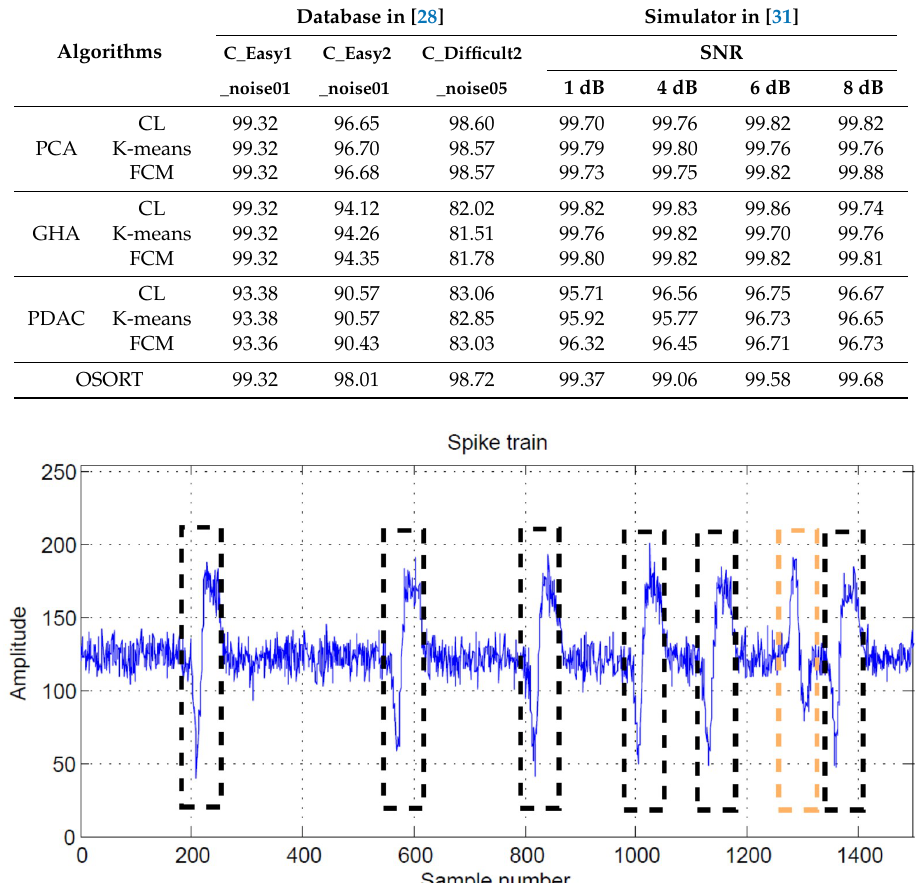
Table 8. The classification success rates (CSRs) (%) of various feature extraction and classification algorithms for spike sorting. The spike trains are obtained from the database in [28] or by the simulator